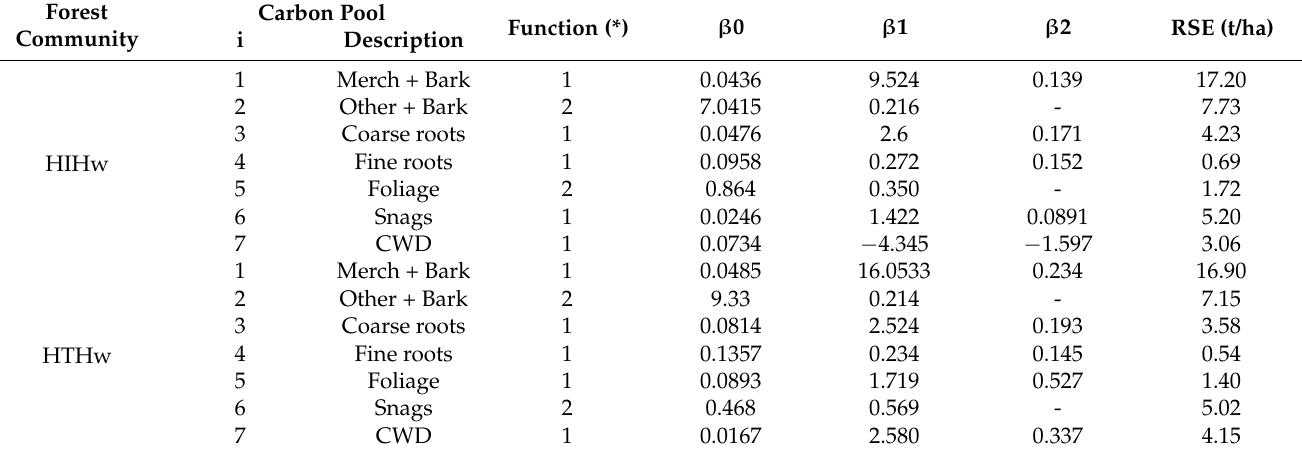
Table 2. Coefficients and residual standard errors for the regressions relating forest carbon to age for each forest community as a function of the carbon pool ( n = 4018). Forest